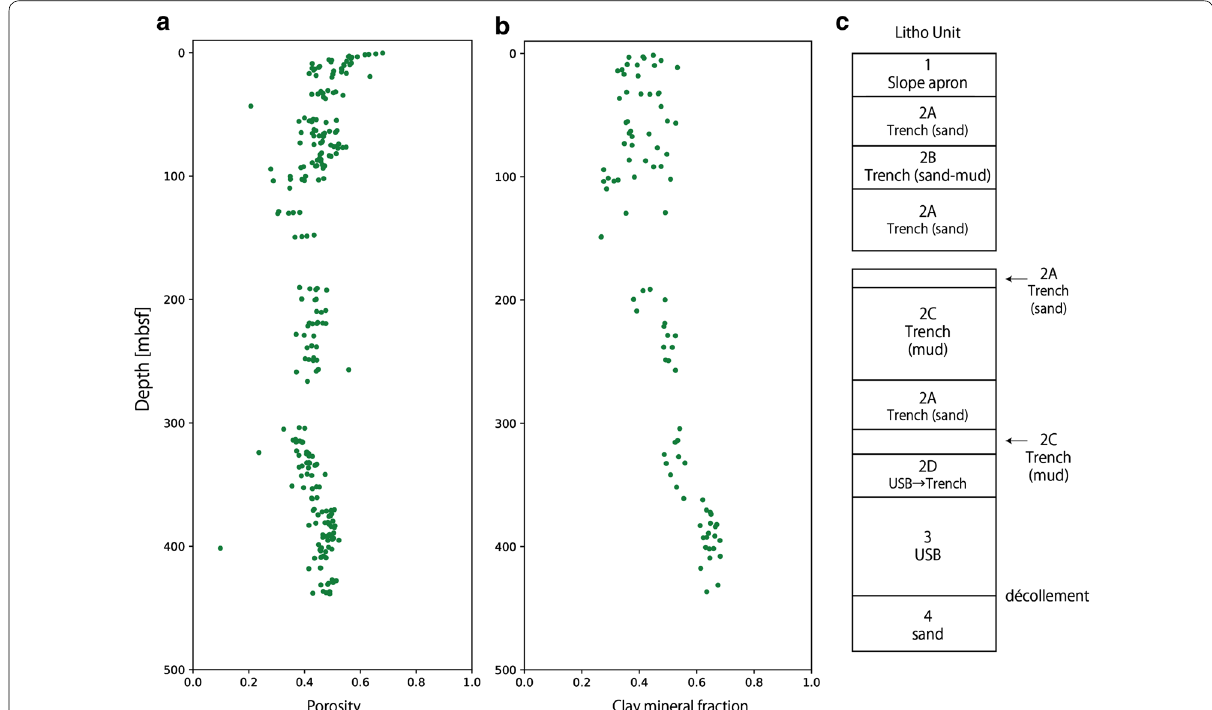
Fig. 9 Data from site C0007. Depth profiles of a porosity and b clay mineral fraction measured from core samples are shown. Lithologic unit descriptions are also shown in